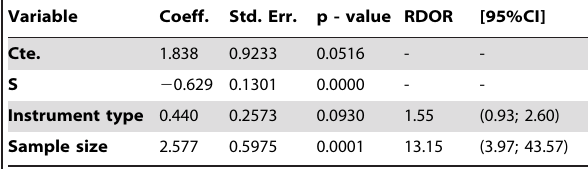
(4) prevalence of samples with mutation, (5) target fragment/ mutation-type analyzed, (6) instrument used (7) dye used, (8) level of analysis (per amplicon and per sample) and (9) length of